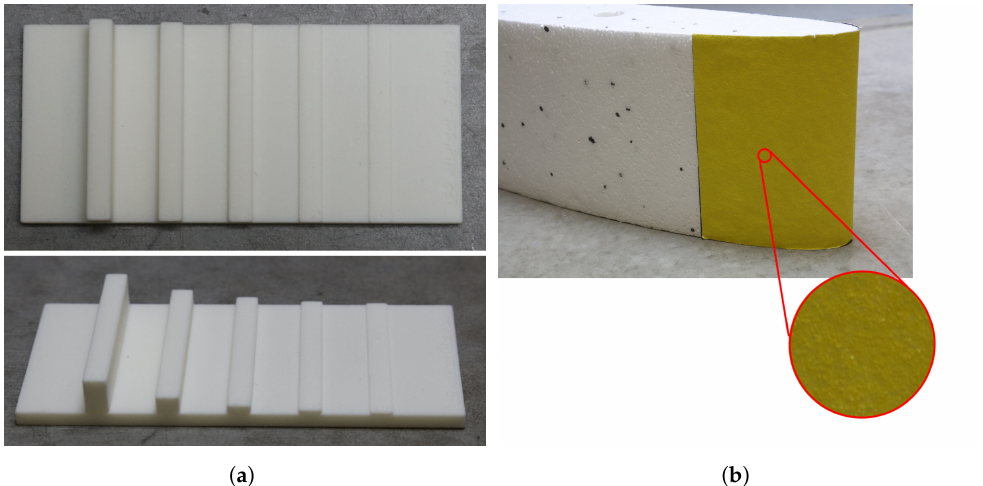
Figure 2. Artifacts for validating reconstructions of the surface topography from macro- and micro- height variations. ( a ) shows the 3D-printed step artifact with nominal heights: 0.63 mm, 1.25 mm, 2.5 mm, 5 mm, and 10 mm. ( b ) shows an example of a foam artifact with the P40 sandpaper attached to it.